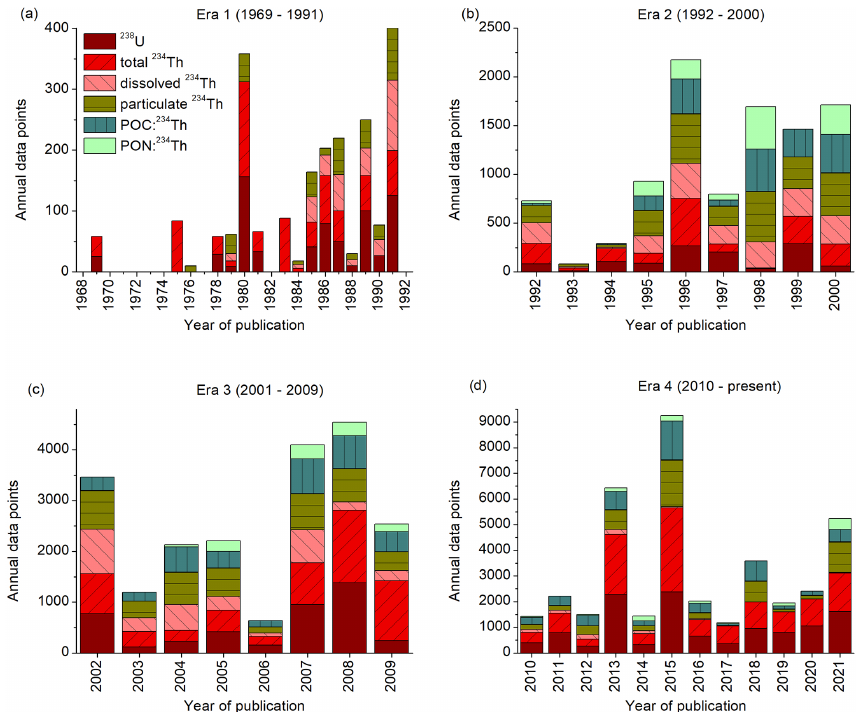
Figure 6. Histogram of data points reported within eras 1 (a) , 2 (b) , 3 (c) , and 4 (d) separated by data type as follows: (i) 238 U, (ii) total 234 Th, (iii) dissolved 234 Th, (iv) particulate 234 Th, (v) POC : 234 Th ratios, and (vi) PON : 234 Th